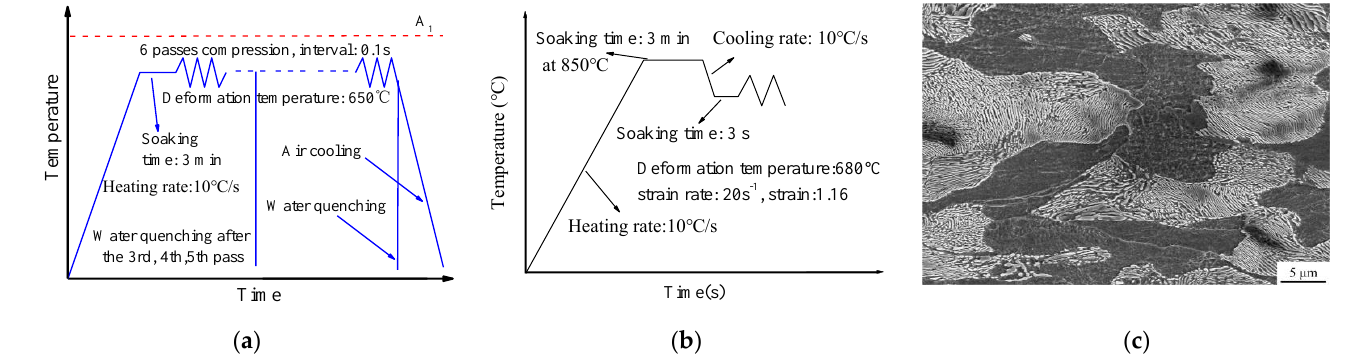
Figure 1. Deformation test scheme; ( a ) Multi-pass plane strain, ( b ) Undercooled austenite defor- mation, ( c ) Initial microstructure of the specimen. Table 1. Multi passes compression strain path of plane strain tests.